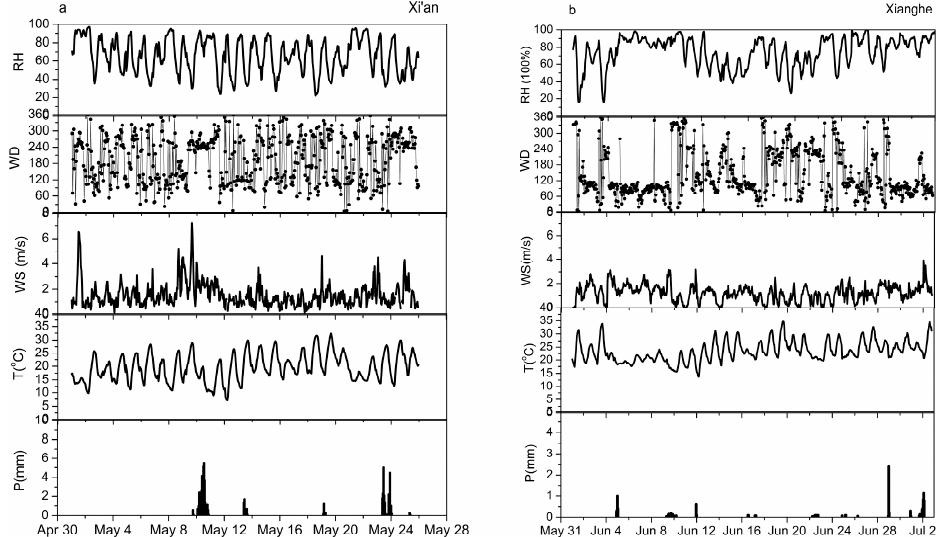
Figure 2. Observed meteorological conditions at the suburban site of Xi’an during 1–25 May 2014 ( a ) and the suburban site of Beijing during 1 June–2 July 2013 ( b